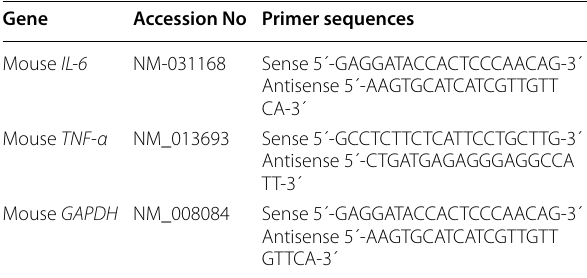
Table 1 Primer sequences used for quantitative reverse transcription‑polymerase chain reaction (qRT‑PCR)